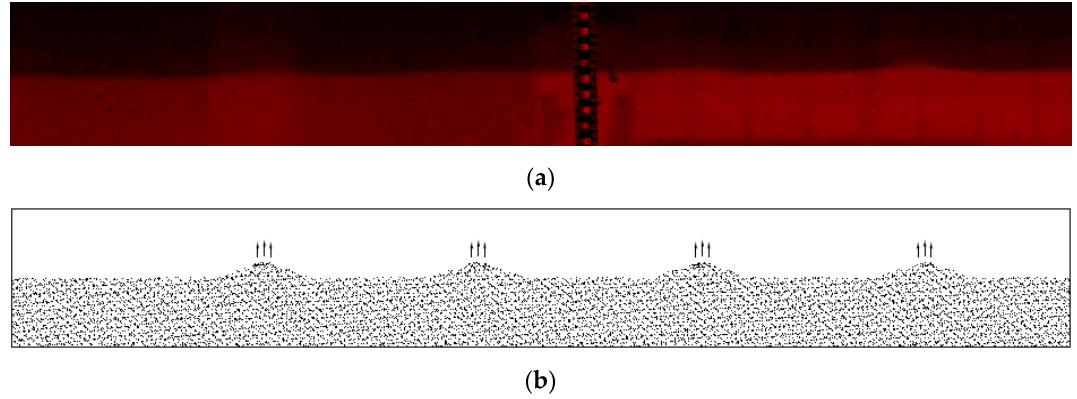
Figure 6. Lateral photograph of a salt-fresh water interface which showed K-H instability. ( a ) Processed image. A small amount of colored water diffused into the upper colorless water at the wave peak. ( b ) Schematic diagram of Figure 5a for clear description. The arrows represent the salinity diffusion.